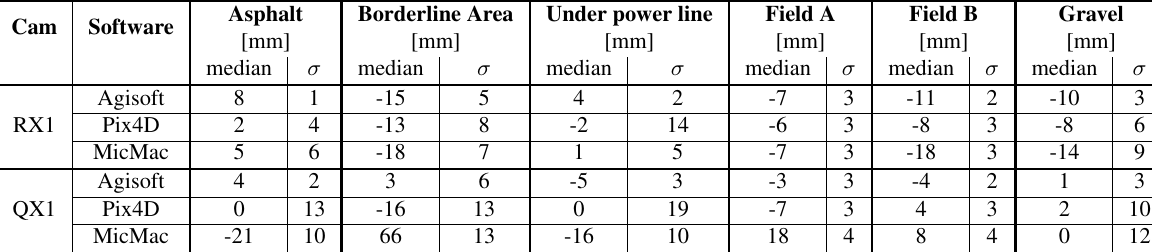
Table 5: For each zone, median and standard deviation ( σ ) distance from the reference LiDAR mean plane to the photogrammetric dense